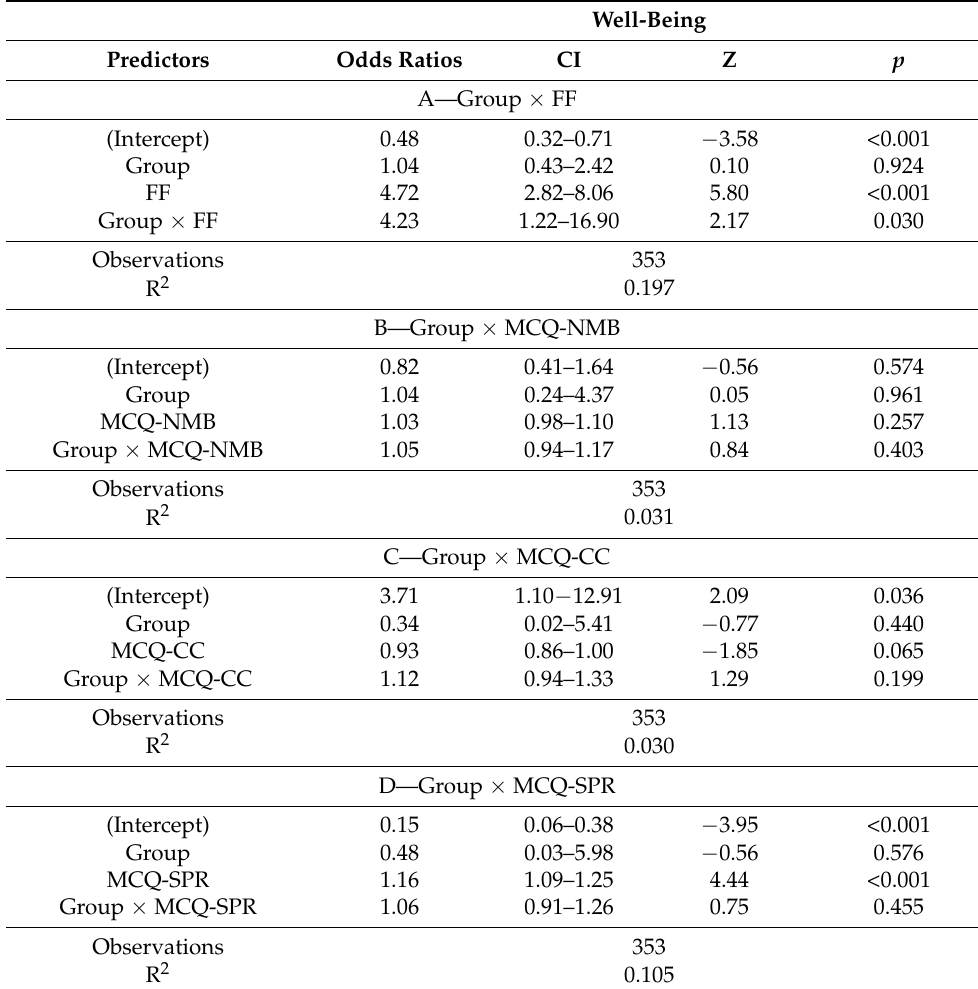
Table A1. Series of logistic regression models for all independent variables and interactions with Group in effect on